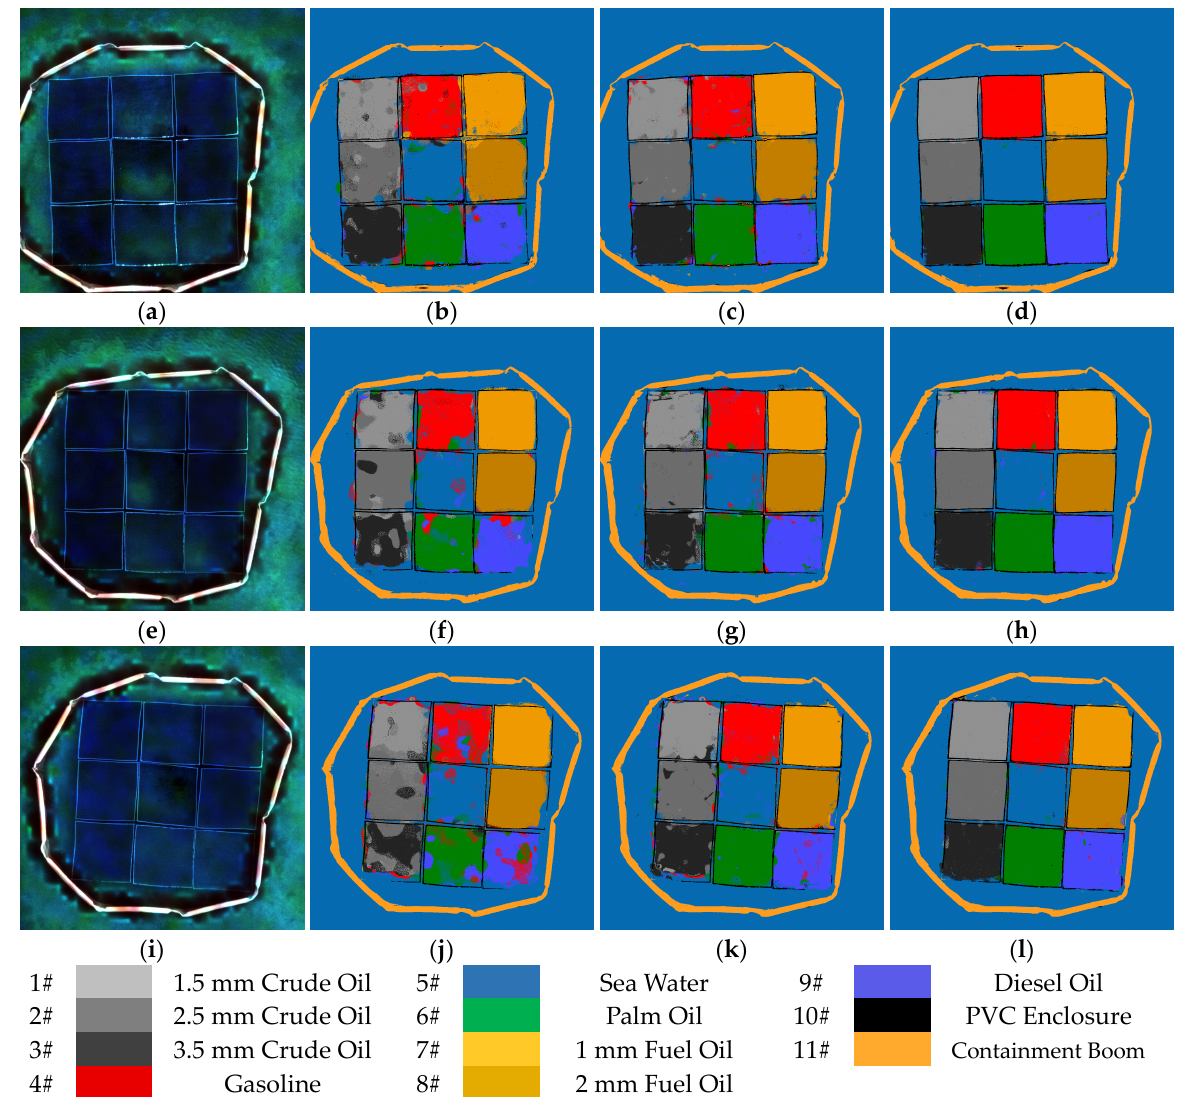
Figure 13. Detection results of the marine oil spill detection model. ( a , e , i ) are true color images at T1–T3, respectively (red: 482 nm, green: 550 nm, blue: 662 nm). ( b , f , j ) are detection results of the SVM model at T1–T3, respectively. ( c , g , k ) are detection results of the GRU model at T1–T3, respectively. ( d , h , l ) are detection results of the 1D-CNN model at T1–T3,